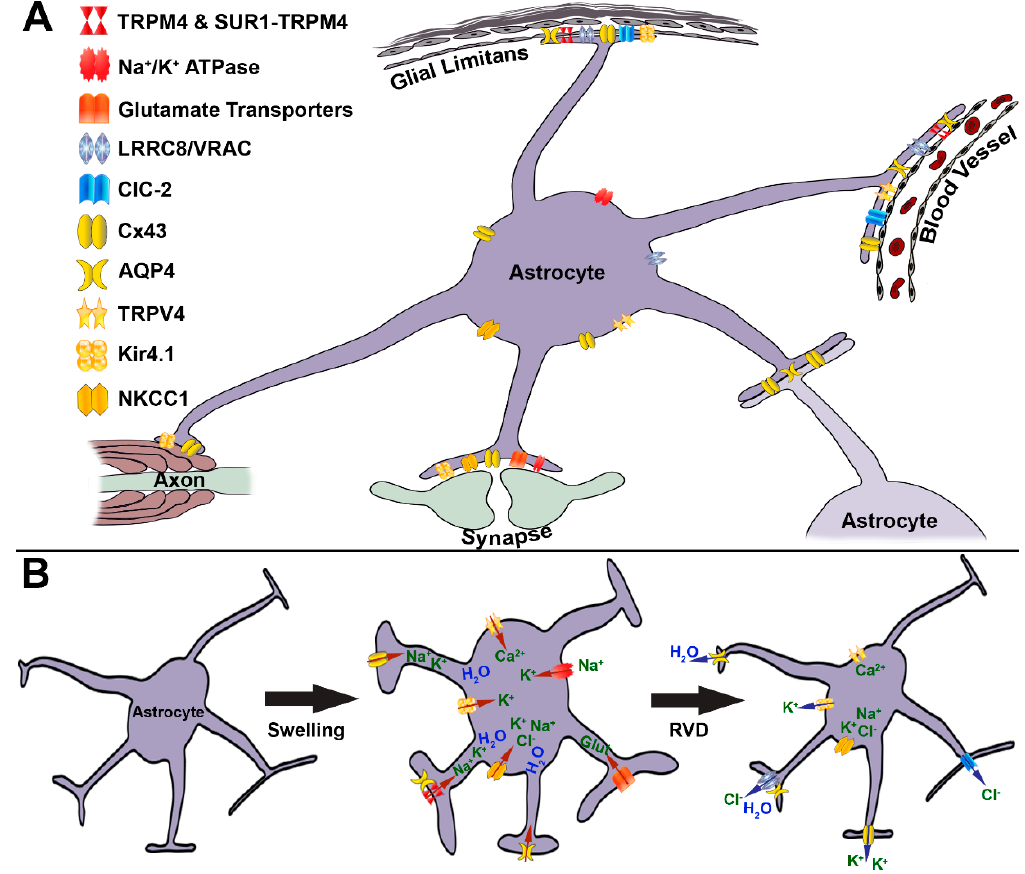
Figure 1. Astrocyte swelling and volume regulation involve multiple complex processes. ( A ) Illustration depicting the major sites associated with movement of osmotically active molecules into and out of astrocytes influencing astrocyte swelling. Astrocytic end feet at both the glial limitans and surrounding parenchymal blood vessels have been well documented to play a role in astrocyte volume change via movement of osmolytes and water. Molecules also move through the panglial